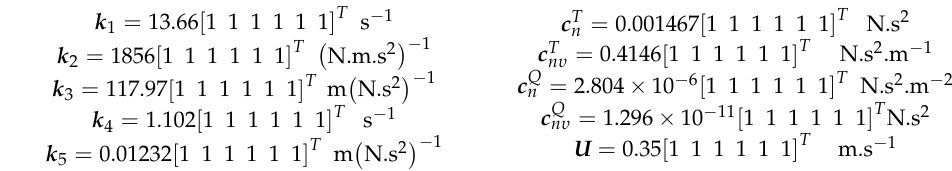
Table 6. The parameters of the thruster hydrodynamic linear models.